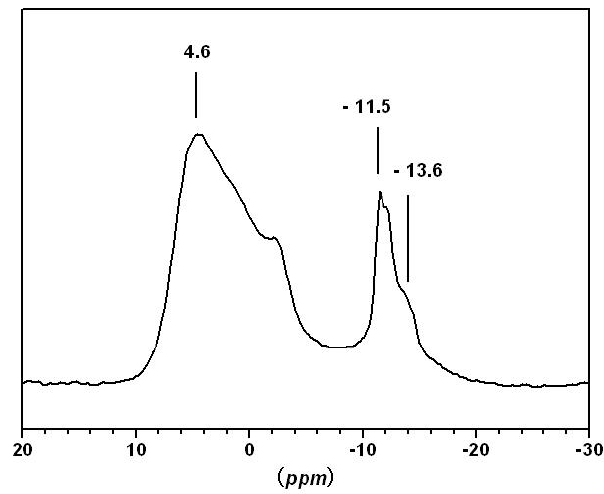
Figure 7. 31 P MAS NMR spectrum of the catalyst.